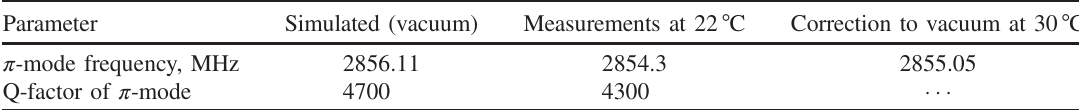
TABLE V. Simulated and measured parameters of the test